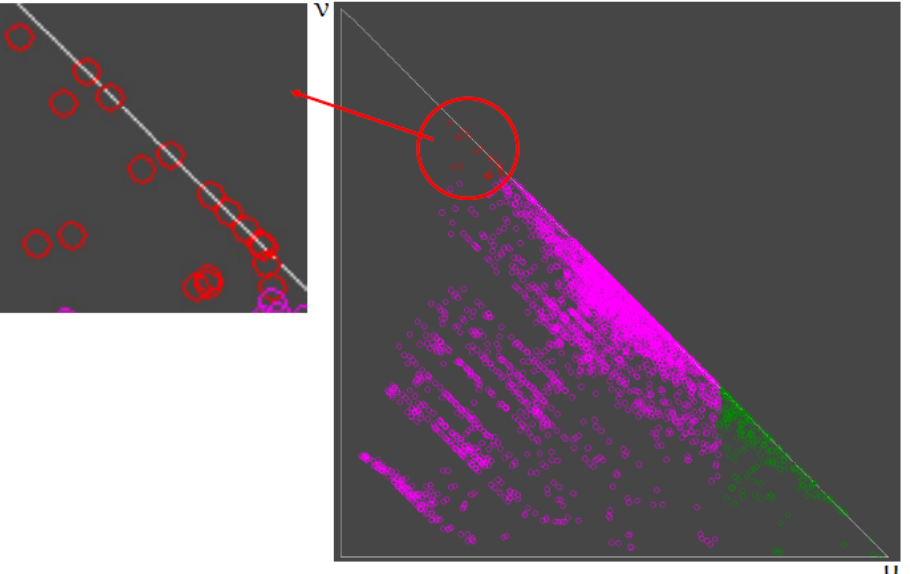
Figure 7. Fifteen criteria pairs that show a high degree of disagreement ν > 0.7, illustrated with red circles. red